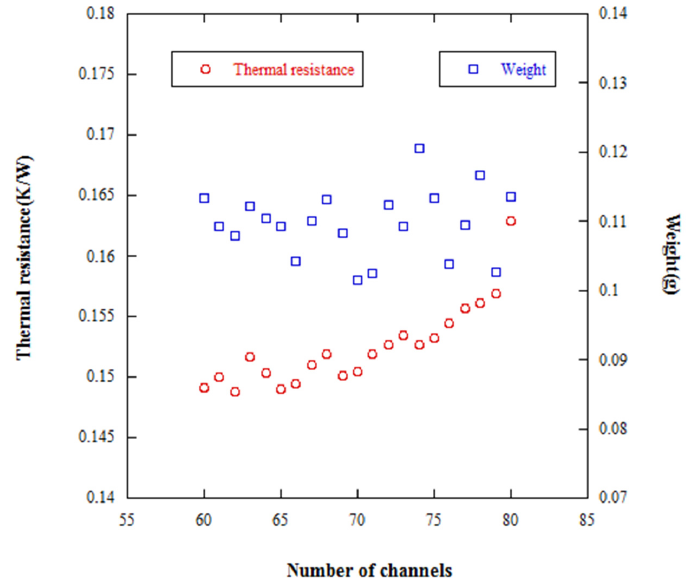
Figure 8. Optimal results of micro channel heat sink with channel number from 60 to